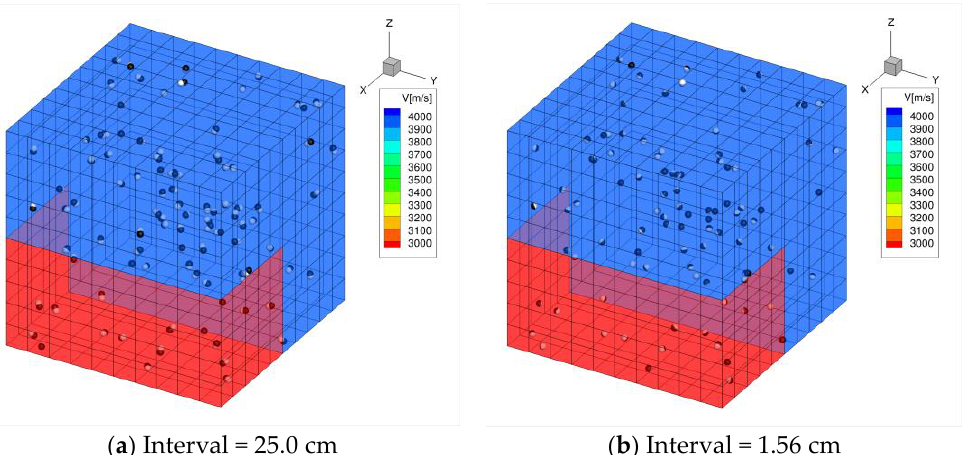
Figure 6. Results of the source localization (black spheres: identified source locations; white spheres: true source